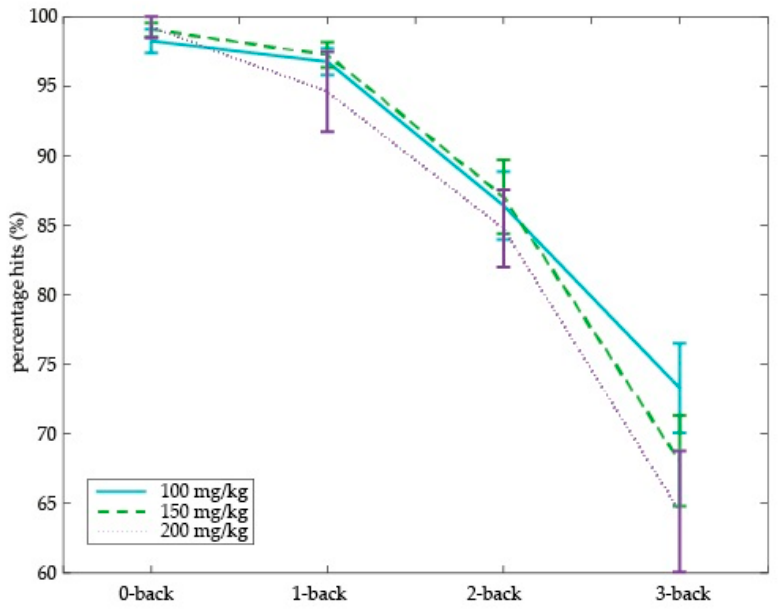
Figure 5. Effect of tyrosine dose on hits in the N-back task as a function of working memory load in older adults. Accuracy is in terms of percentage hits with Standard Error of the Mean (SEM).